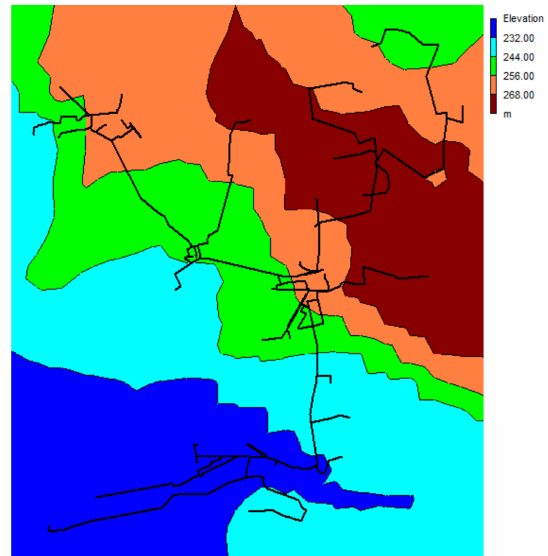
Figure 1. Altitude profile of the analysed